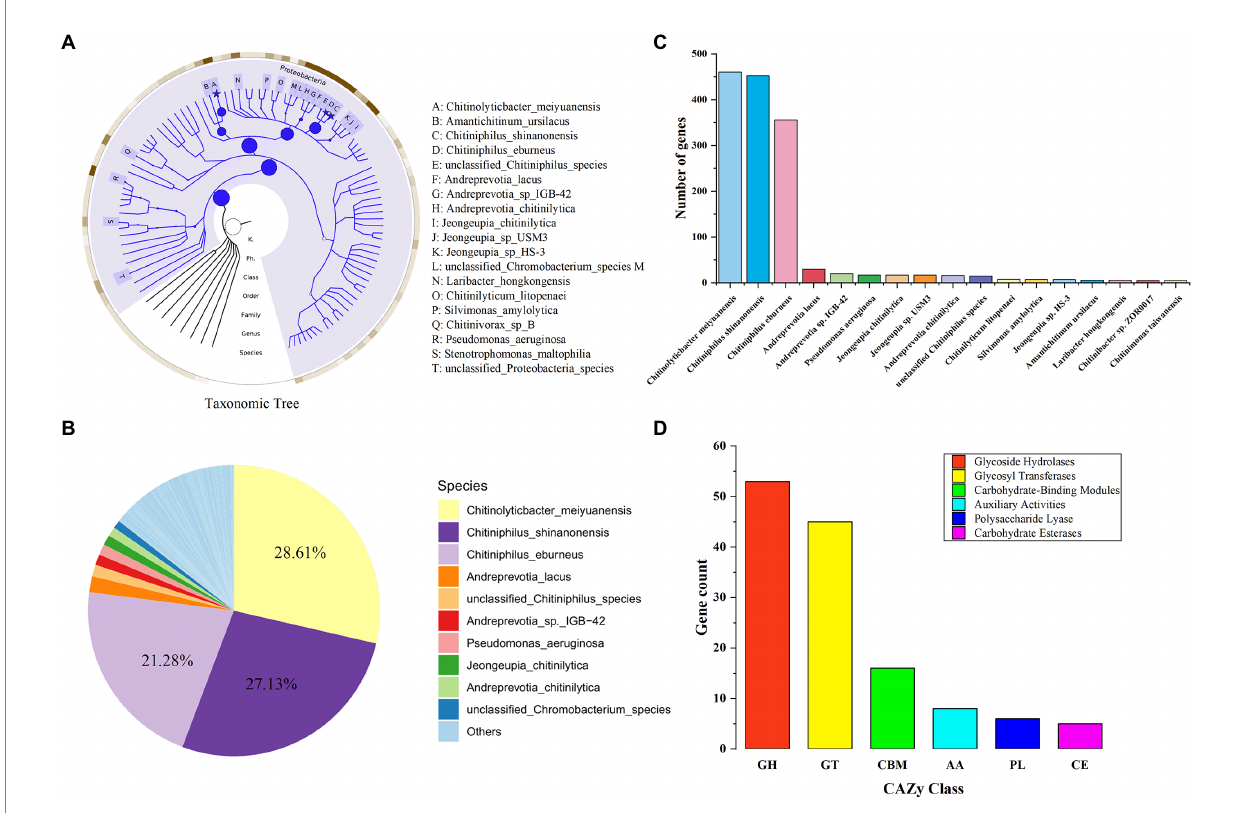
FIGURE 2 Metagenomics analysis of LNM32. (A) Phylogenetic tree of the microbial metagenome-assembled genome from the LNM32. The size of the circle and asterisk represents the abundance size; (B) Relative abundance at the bacterial species level; (C) The number of genes annotated to different species (shown in top 90%); (D) The number of genes annotated as each CAZy